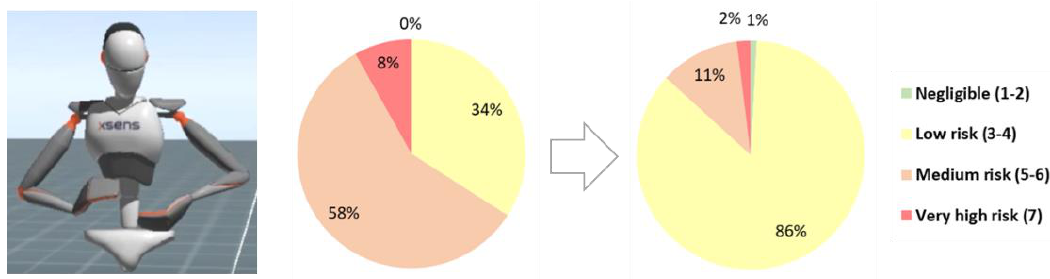
Figure 3. Ergonomic evaluation of as – is process and potential benefits obtainable with HRC.